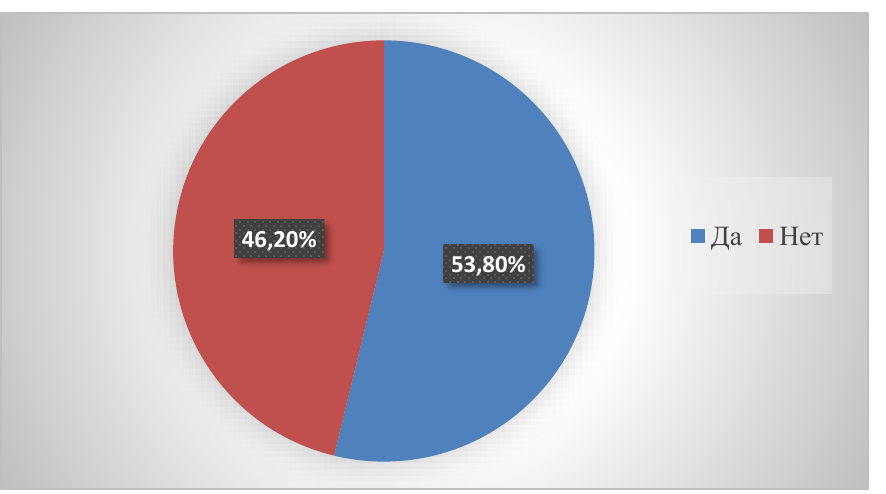
Fig 5. The respondents’ answers to the question “Would you like to be a member of one of the families in the